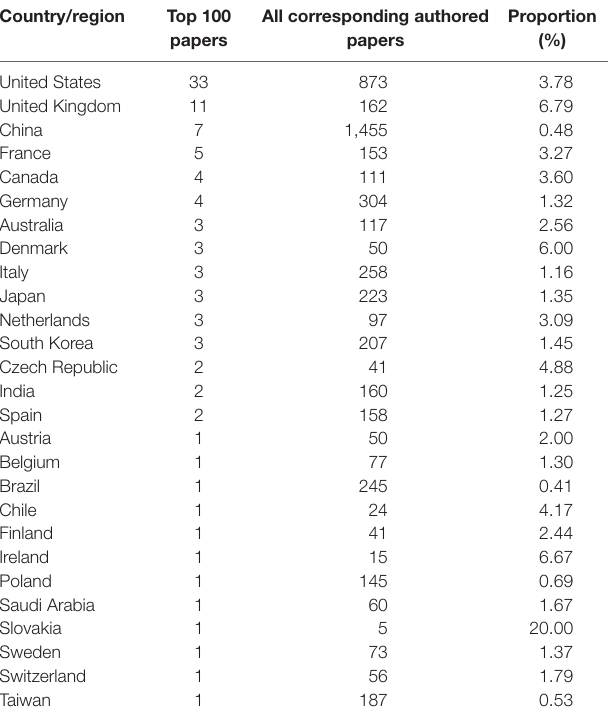
Table 2 | Percentage of top papers by country (based on the location of first author’s affiliation). country/region